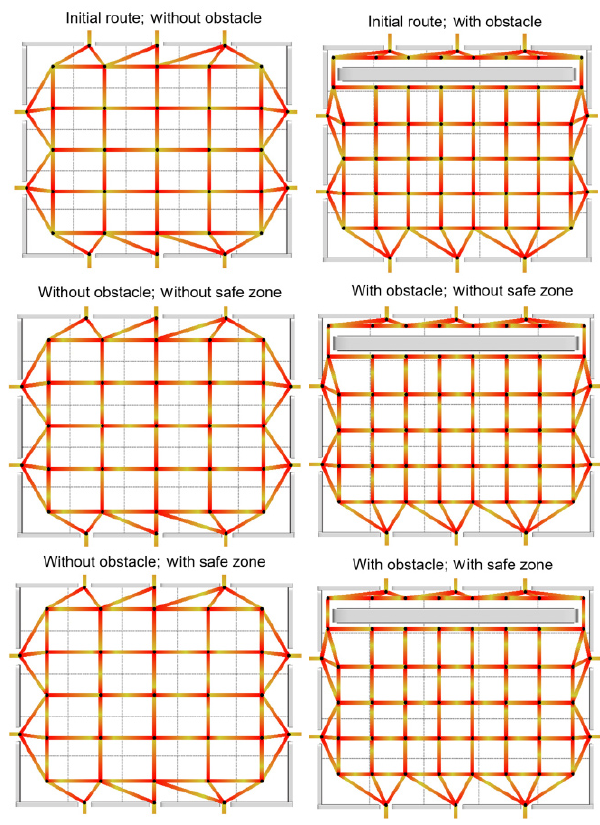
Fig. 18 The initial routes and optimal routes in our method. Top row: initial routes. Middle and bottom: optimal routes. The computed routes with and without safe zones are similar to each